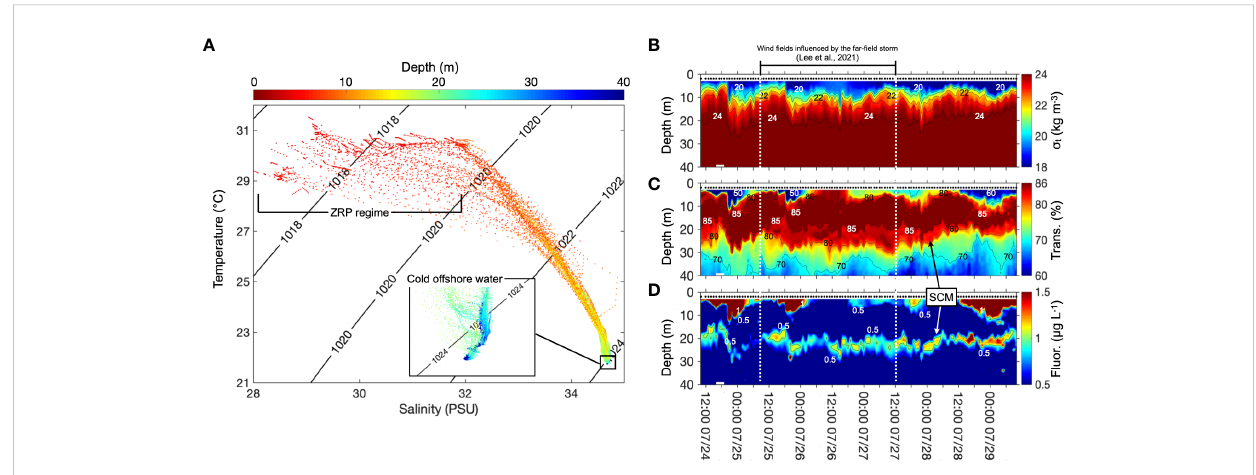
FIGURE 3 Hydrographic measurements at ZHJ2 including (A) The depth-referenced T-S diagram in which the color bar indicates the depth of the measurement. Warm colors represent shallower depths and cold colors represent deeper depths. The inserted graph is the enlarged section of the T-S diagram at the bottom marked by the black square. The temporal changes in 2-D structures are shown in (B) the water density, (C) the light transmission, and (D) the fl uorescence. White dash lines in (B-D) mark the duration of the storm in fl uence. Arrows point out the SCM.